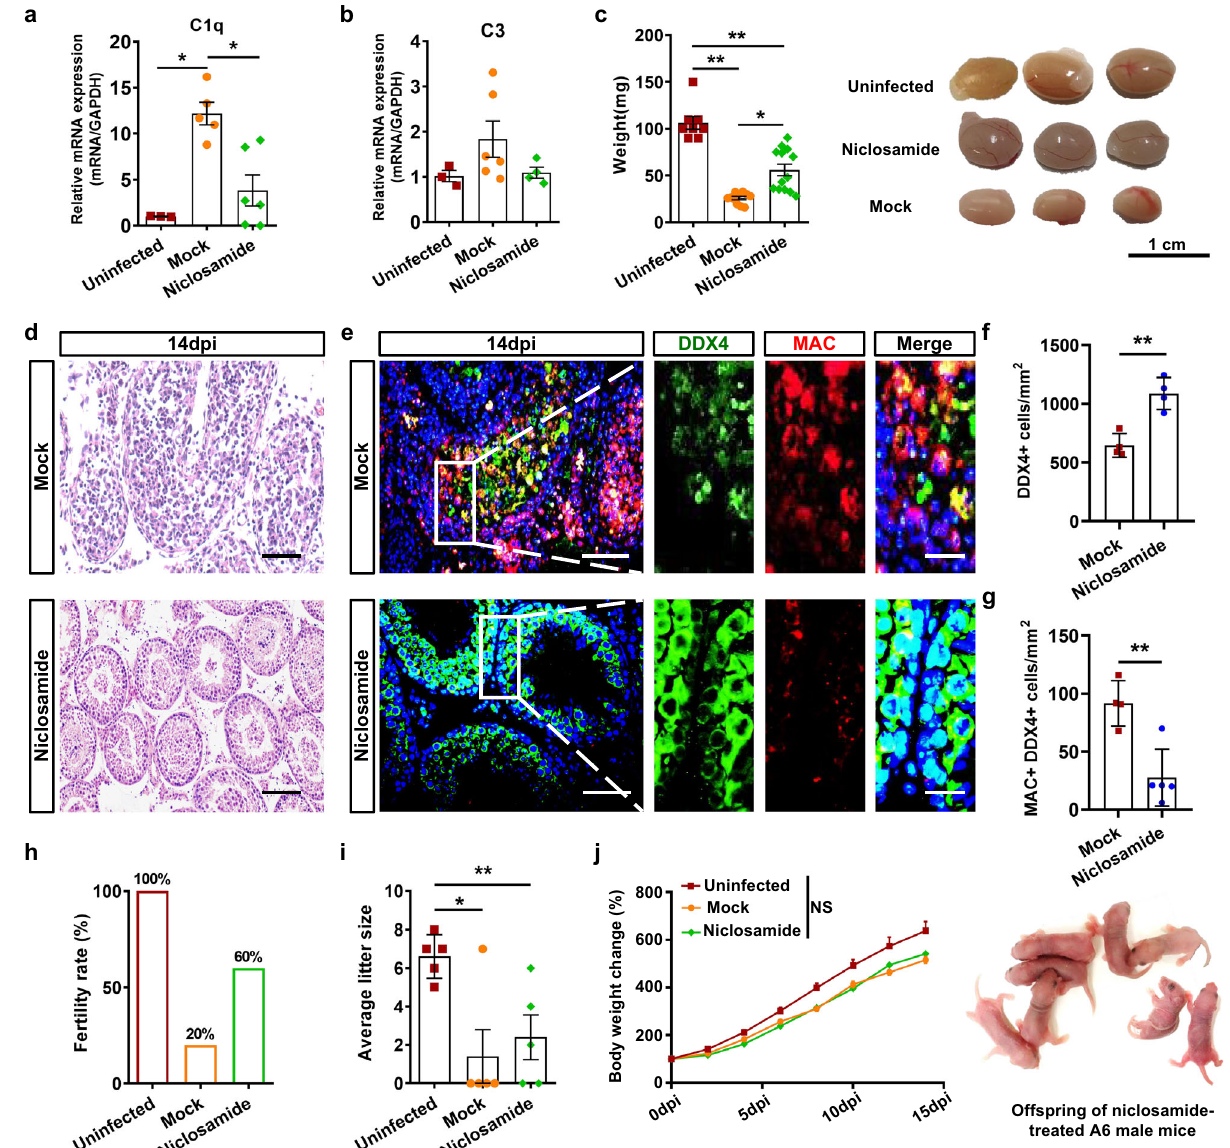
Fig. 8 | S100A4 inhibitor niclosamide alleviated ZIKV-induced spermatogenic cells damage. a , b The relative mRNA expression levels of C1q ( a ), and C3 ( b ) in testes at 14 dpi were measured by RT ‒ qPCR. Results were shown as means±SEM and analyzed using the two-sided Student ’ s t test. * p <0.05. ( n =3 mice for unin- weight and representative pictures of testes in at 14 dpi. Results were shown as means±SEMandanalyzed usingthetwo-sidedStudent ’ s t test.* p <0.05,** p <0.01 ( n =8 testes for uninfected, n =11 testes for mock-infected, and 13 testes for niclosamide-treated). d HEstainingoftesticularsectionsat14dpi,Scalebar,50 μ